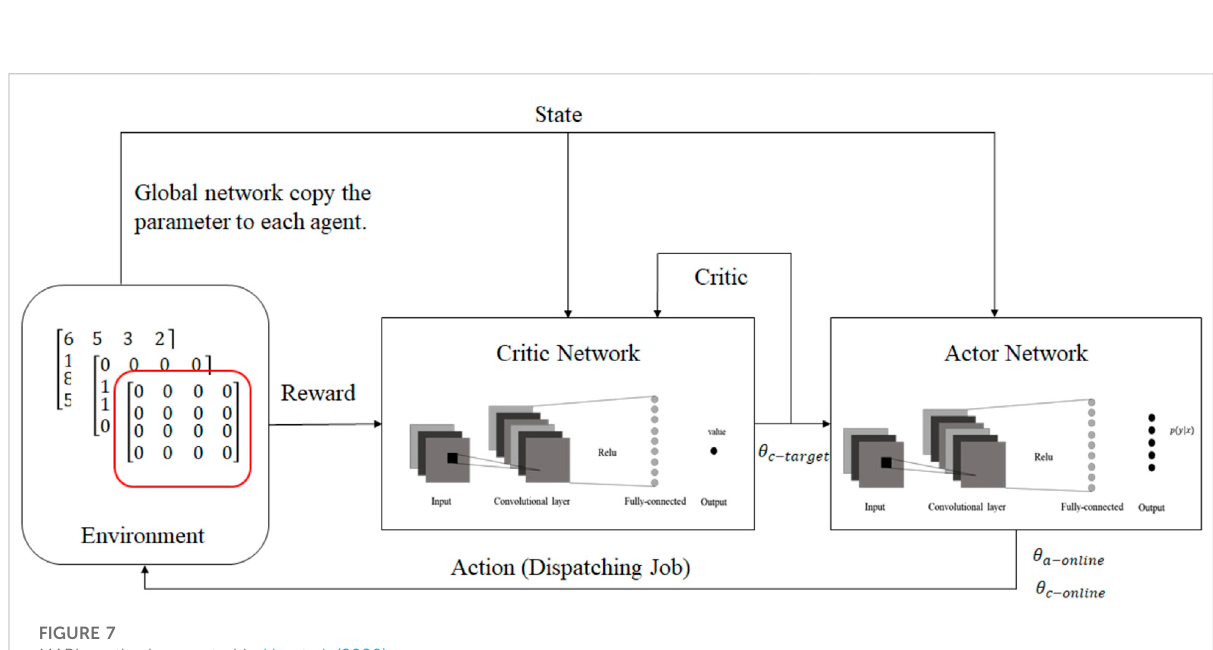
FIGURE 7 MARL method presented in Liu et al.